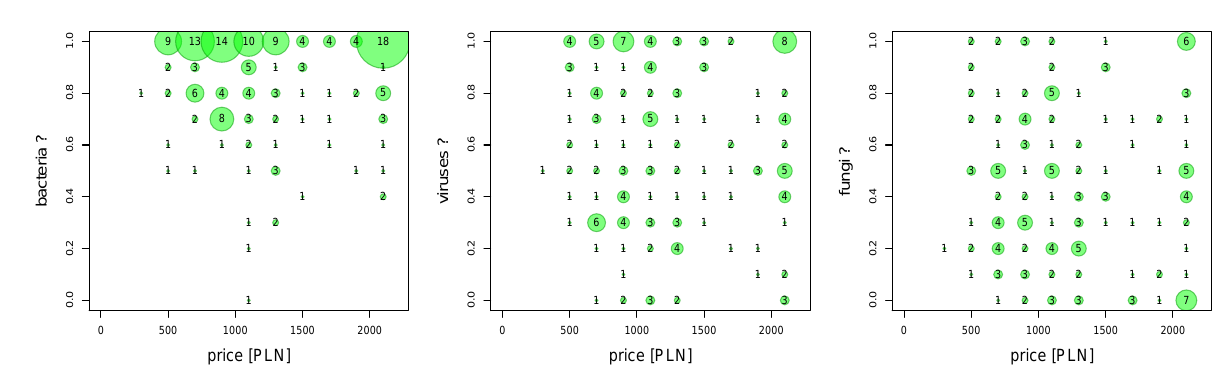
Figure 2. Associations “Do you think there are bacteria/viruses/fungi on touch screens?” and smartphone market price (prices above 2100 PLN are saturated).